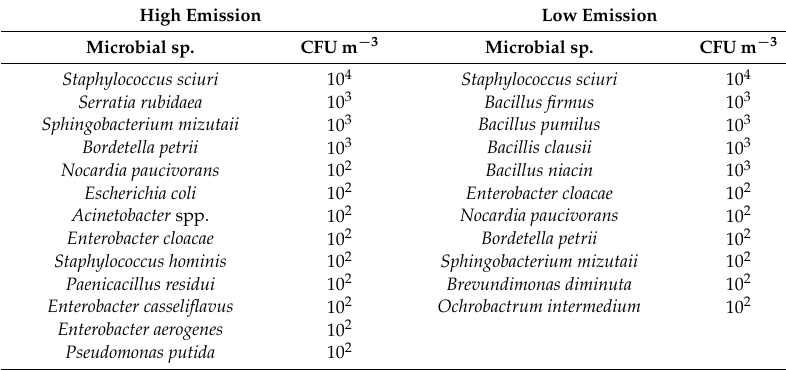
Table 6. Predominant organisms detected by MALDI-TOF in air samples during low and high emission scenarios (approximate concentration CFU m − 3